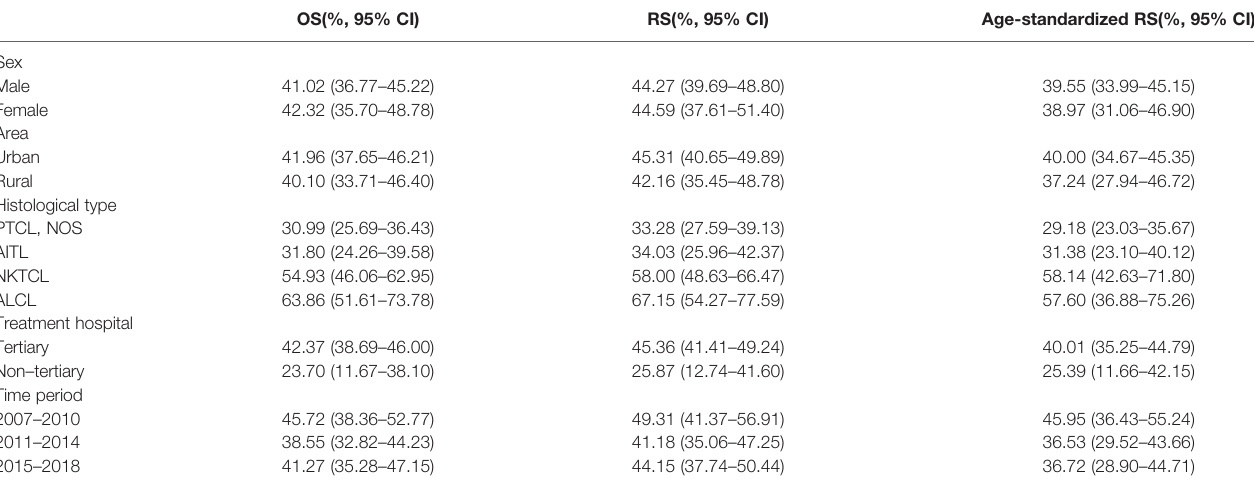
TABLE 4 | Five-year survival by sex, area, histological type, and treatment hospital of peripheral T-cell lymphoma in Beijing from 2007 to 2018. OS(%, 95% CI) RS(%, 95% CI) Age-standardized RS(%, 95% CI)